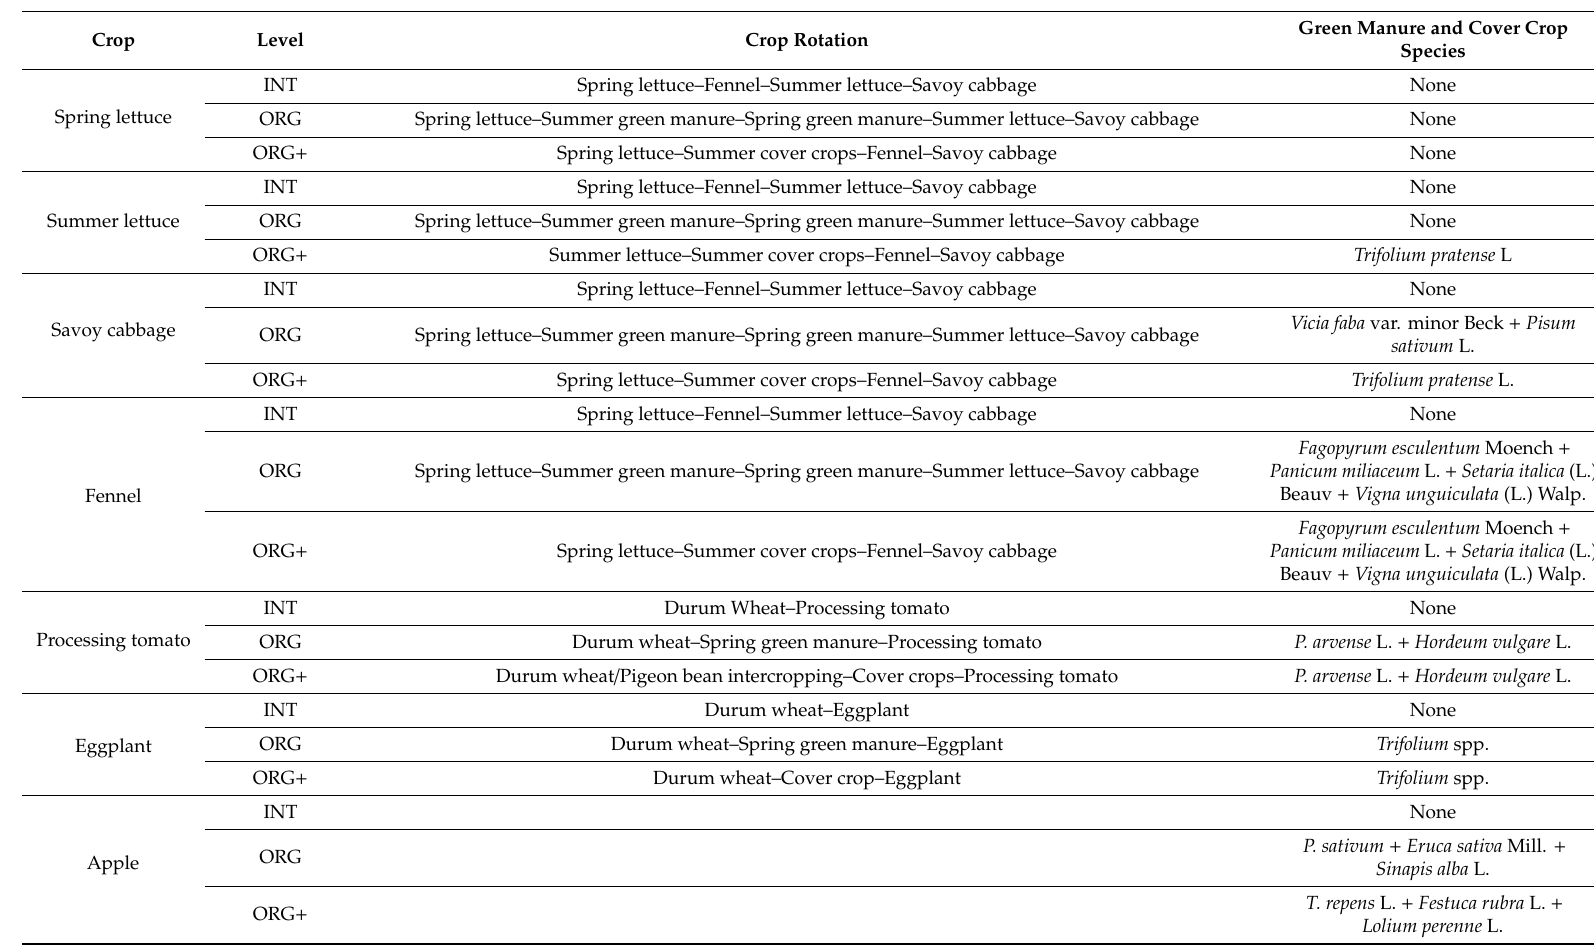
Table 3. Crop rotation in the three di ff erent cropping systems during both experiment years for each crop under investigation, except for